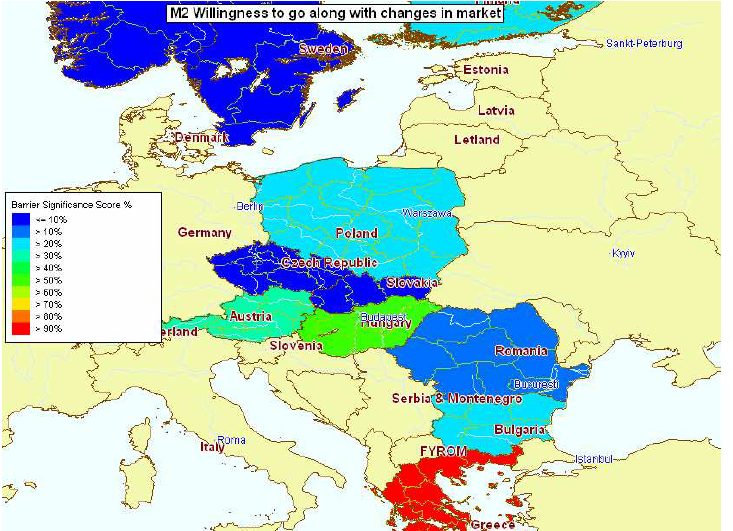
Figure 6. Relative BSS for implementation condition M2 (willingness to go along with changes in the market), BSS for Greece =